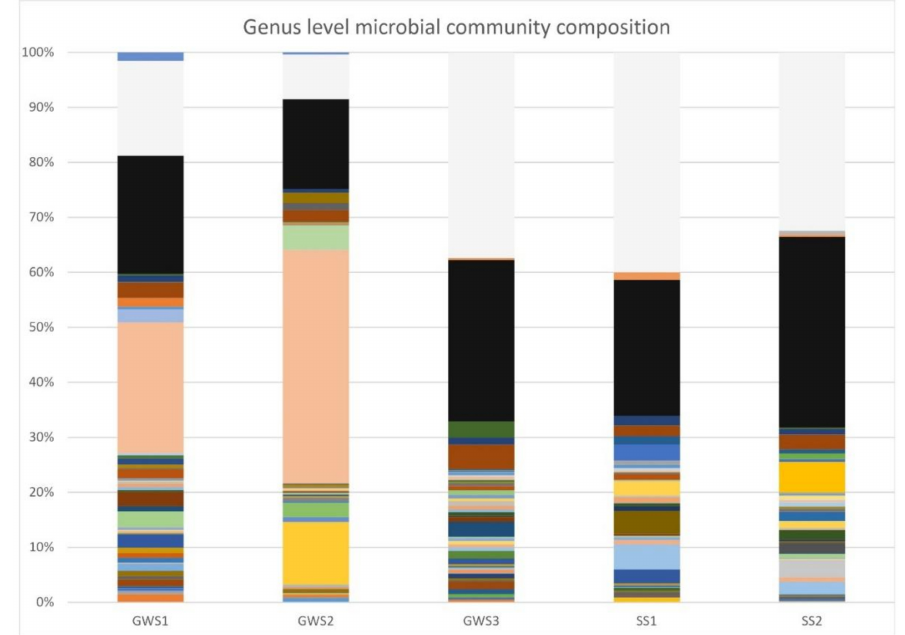
Figure 7. Genus level microbial community composition in samples collected from groundwater and soil: Unclassified bacterial genera are reported in light grey. Taxa with relative abundance below 0.5% are reported in black. The remaining colours indicate identified bacterial